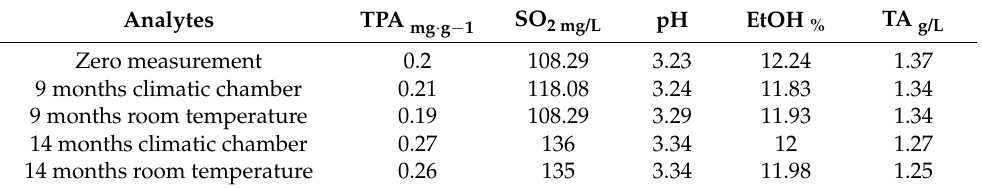
Table 11. Basic oenological parameters. Biologically active substances. Pinot noir sweet. Basic oenological parameters . Sample F—Pinot noir sweet, harvest 2016.